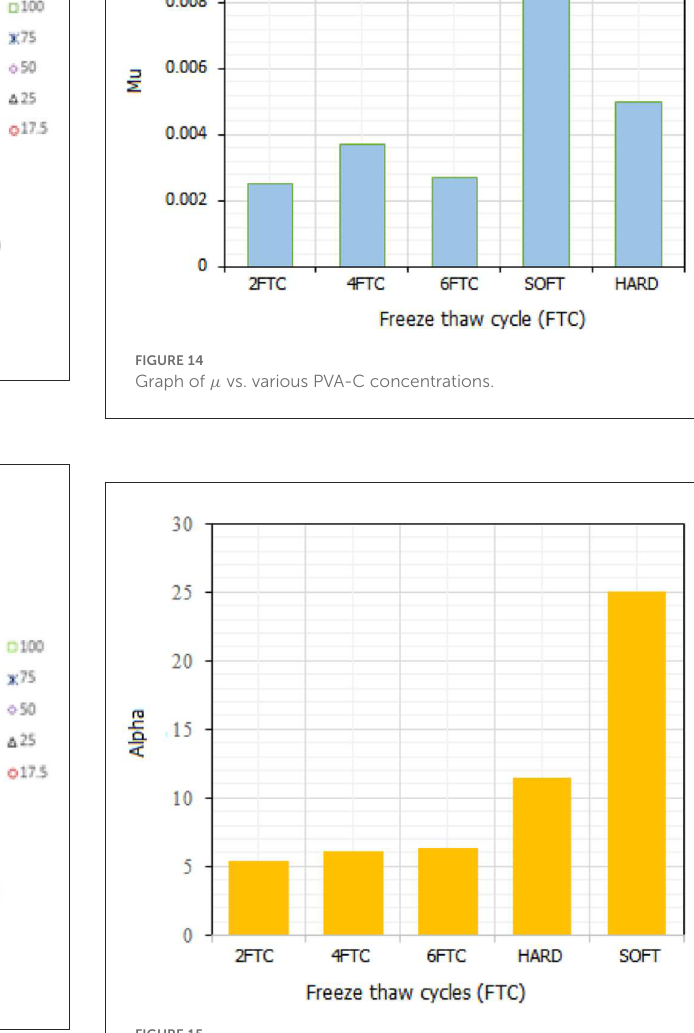
FIGURE15 Graph of α vs. various PVA-C